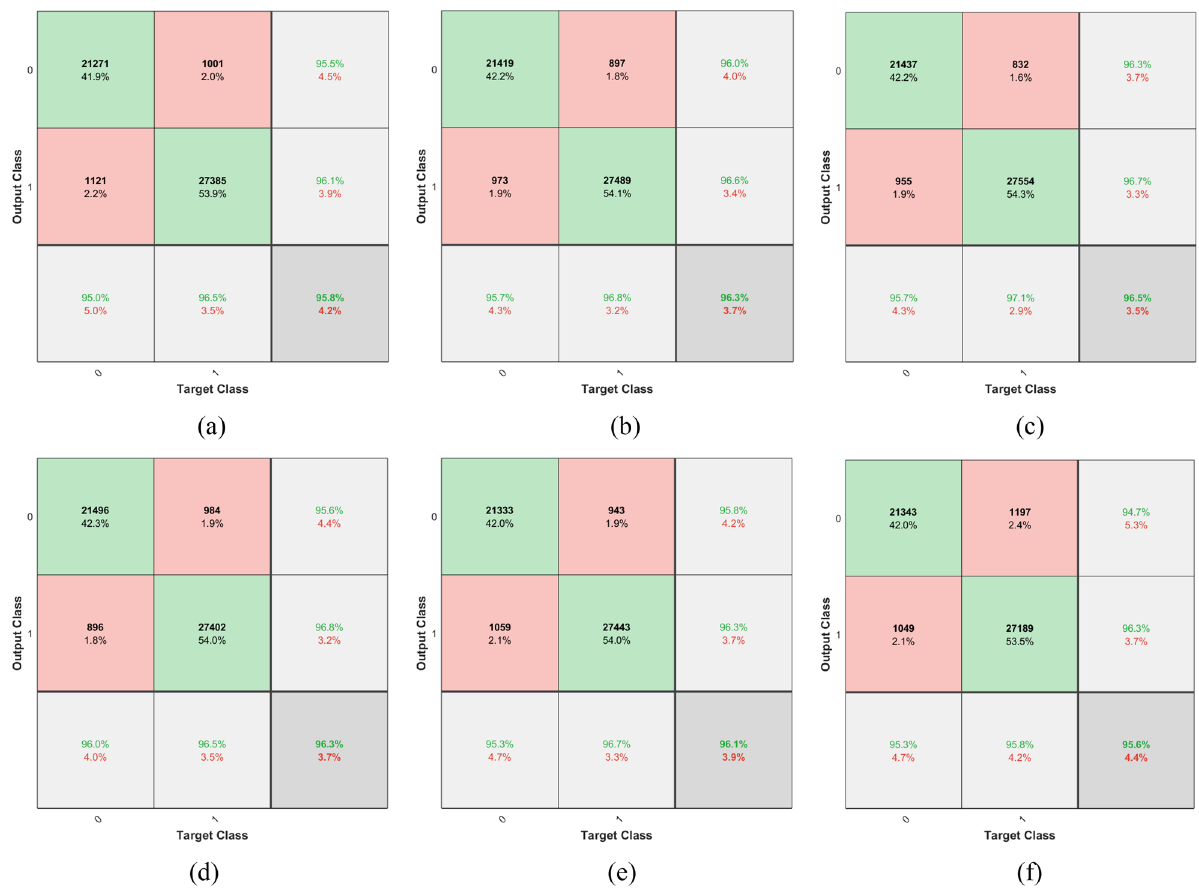
Figure 9. Confusion Matrices (based on the best of ten) for the k -NN classifier ( k = 1) using proposed DLRFE module for backbone learning using BraTS-2021 dataset with RA to improve the discrimination of the features using epochs as: ( a ) 1, ( b ) 5, ( c ) 10, ( d ) 25, ( e ) 30, and ( f ) model with high variance exhibits compromised performance on unknown instances. Figure 10d shows a similar trend for MCC indicating the performance improvement using RA for the original dataset. Figure 10e shows the AUC (ROC) plot showing the marked improvement with RA. Figure 10f follows the P r trend indicating the performance rise due to RA. Figure 10g shows a similar trend of R c with and without RA. A careful look at Table 5 indicates that the prediction discrimination threshold between positive and negative sides appears to increase S n , by moving towards the latter, reducing FNs as illustrated in Table 7 showing the cross-validated (tenfold) distribution of confusion matrix components for different epochs runs for latent features extraction. At the same time, S p decreases due to increased FPs following the same logic. A similar trend is encountered between P r and R c as that of S p and S n respectively. There is a slight decrease in R c with RA due to a slight increase in FN but at the same time has the effect of raising S p from (70.48 ± 0.00)% to (97.08 ± 0.10)% using Tables 5 and 6 respectively at epochs = 5 with k -NN for k = 1. The overall effect of RA is a balanced increase in S p and S n , i.e. (97.08 ± 0.10)% and (95.86 ± 0.14)% respectively as illustrated in Table 6 ( k -NN with k = 1, epochs = 5). It can be inferred that high S n ( ↓ FNs) is accompanied by positive results and high S p ( ↓ FPs) leads to healthy subjects. Figure 10h shows the comparison of higher to lower NPV trends. This can be explained based on previous findings. Figure 10i plot has been based upon NPVs with and without RA. The latter has shifted the predictive threshold boundary to the negative side so that FNs are reduced. In the case of RA based NPV plot, the predictive threshold boundary between positive and negative subjects is balanced in such a way that so that the false events are almost equally divided across it, as illustrated in Table 7. This results in balanced PPV and NPV values. At relatively higher epoch values, for getting deep learning features, the NPV is higher in comparison to the NPV without RA because of a relatively lower number of FNs (Table 7). SVM model. Three important variants of SVM classifier using linear, polynomial kernels of order ∈ (2,3,4) and radial basis function (RBF) have been experimented with to classify HFS into MGMT+ and MGMT− classes using latent features. The polynomials of higher-order (> 4) were not able to generate significant results. The results using SVM for binary classification of BraTS-2021 with RA using latent features extracted at the fifth